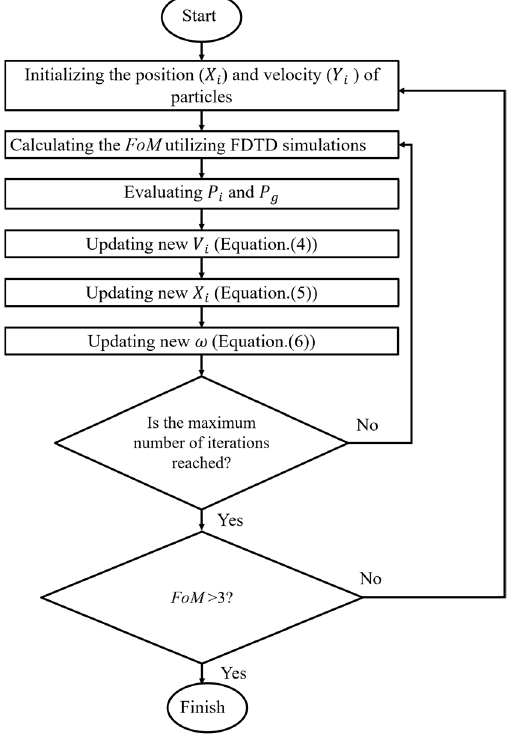
Figure 3. The flow chart of PSO algorithm.